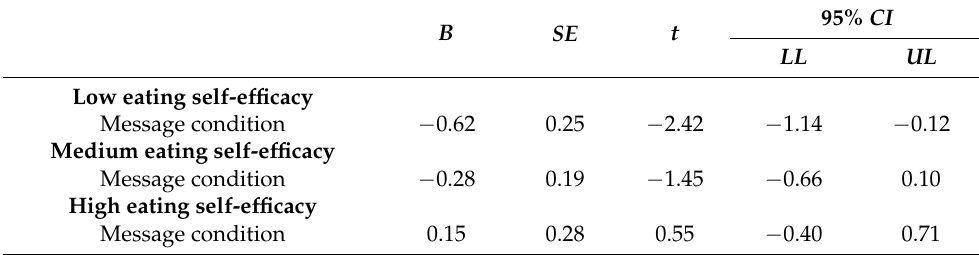
Table 4. Conditional effects of message condition at different values of the moderator. 95% CI B SE t LL UL Low eating self-efficacy Message condition − 0.62 0.25 − 2.42 − 1.14 − 0.12 Medium eating self-efficacy Message condition − 0.28 0.19 − 1.45 − 0.66 0.10 High eating self-efficacy Message condition 0.15 0.28 0.55 − 0.40